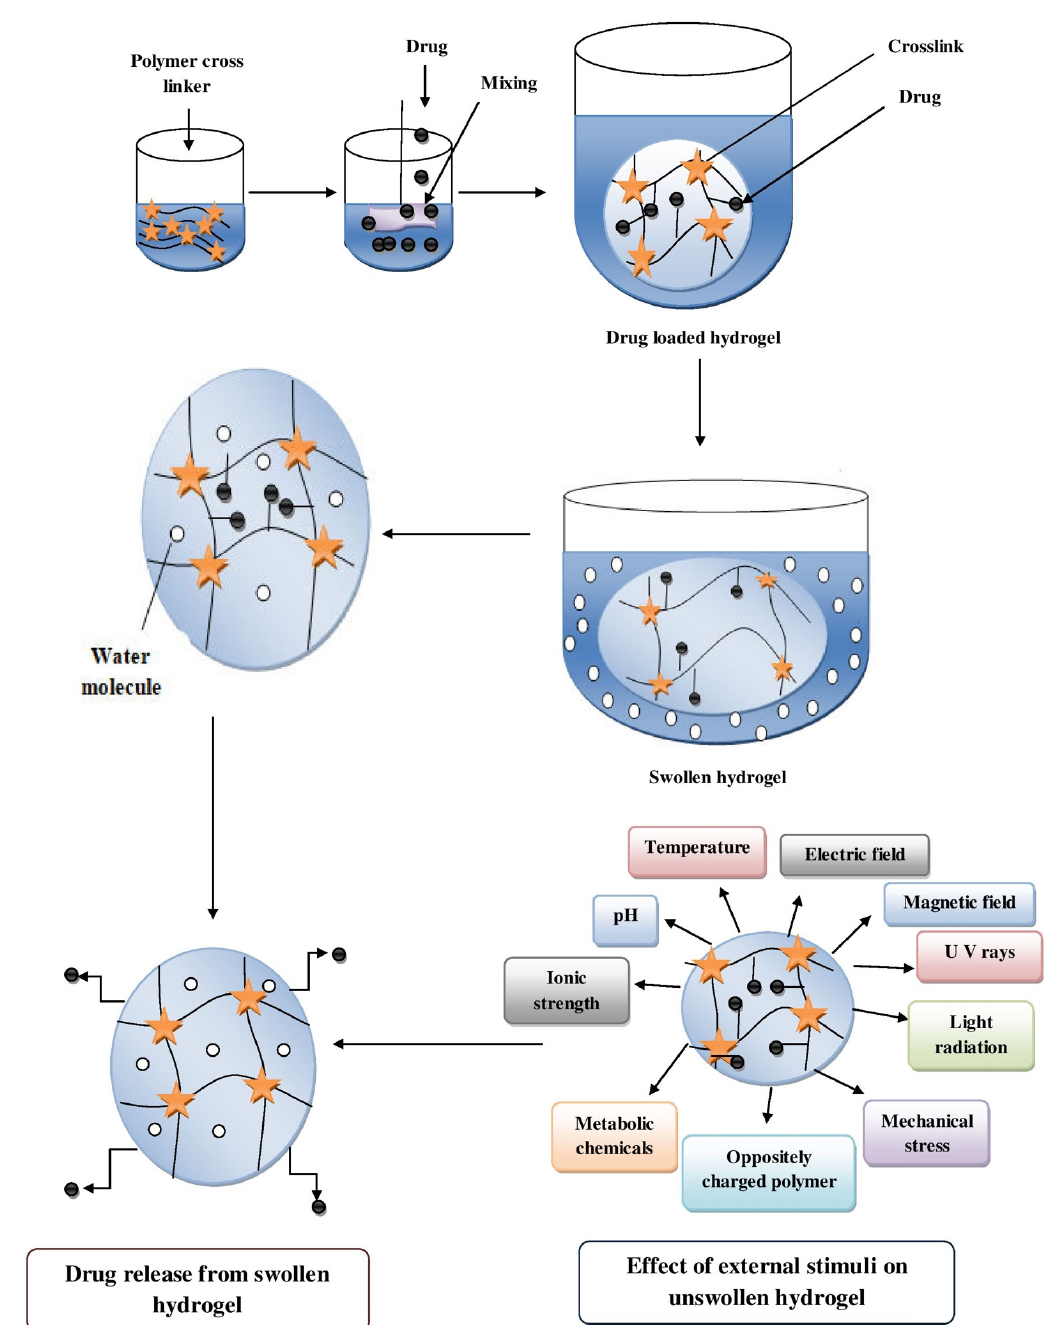
Figure 4 . Mechanisms of drug release from hydrogel. Figure 4. Mechanisms of drug release from